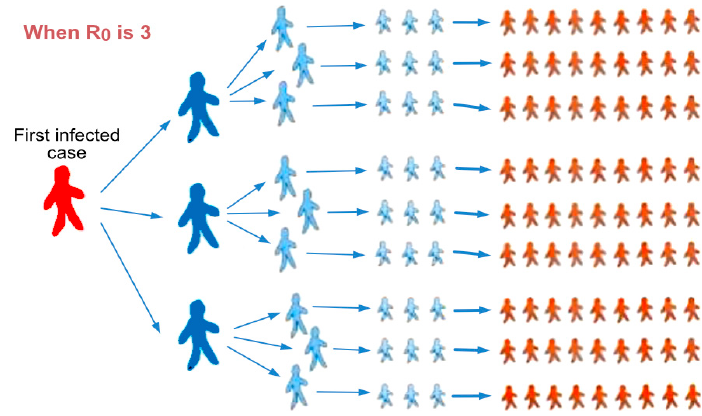
Figure 1. The basic reproduction number ( R 0 ) represents an indication of the initial transmissibility of the virus. Courtesy of Qatar Biomedical Research Institute (QBRI).